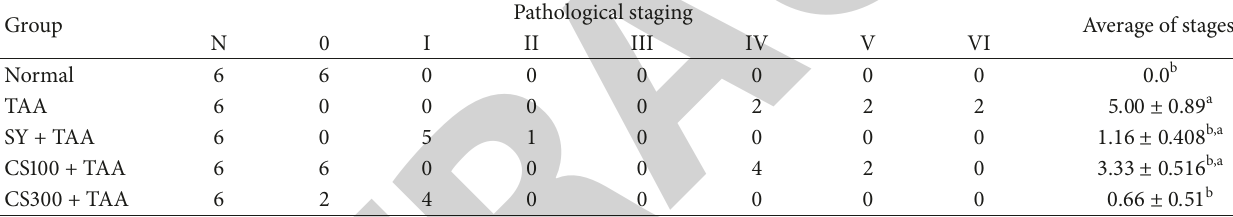
Table 2: Scoring of fibrosis for the different groups.